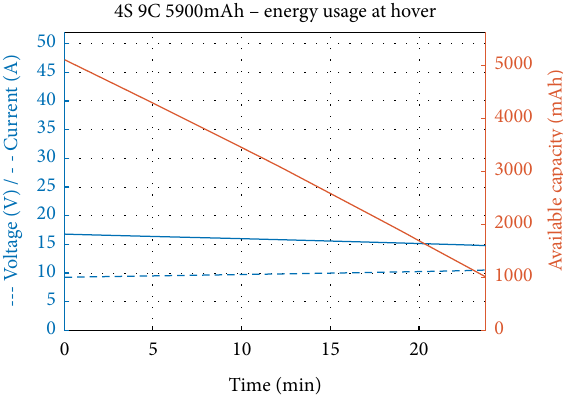
Figure 8: Example battery behaviour during